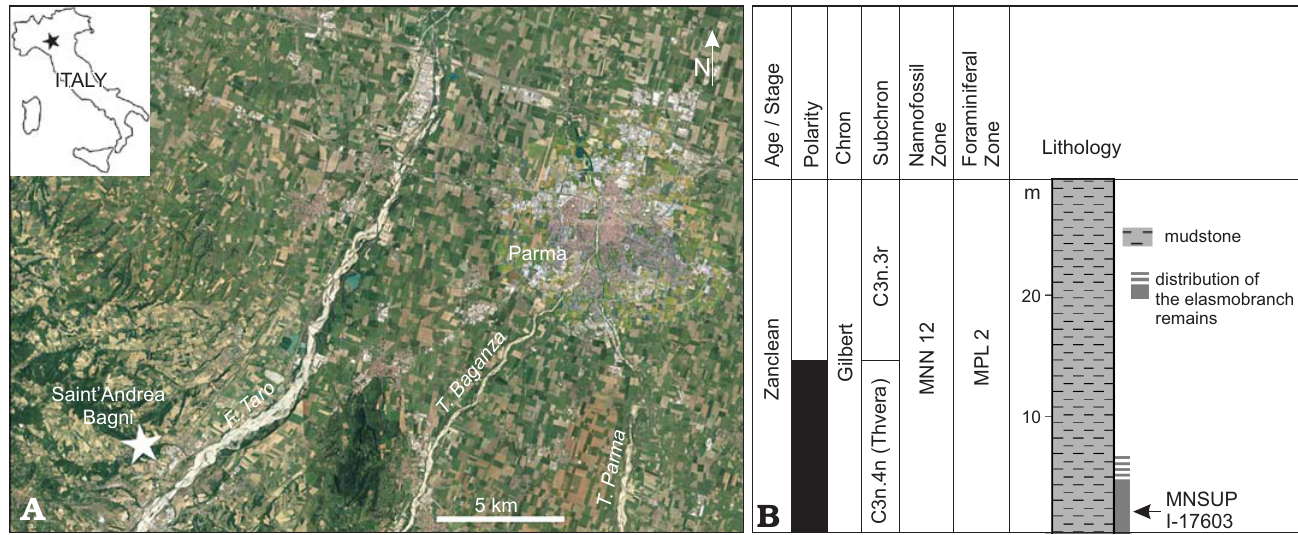
Fig. 1. A . Geographical position (star) of the lower Pliocene site of Sant’Andrea Bagni, Northern Apennines, northern Italy, where the holotype of Pliokogia apenninica gen. et sp. nov. (MSNUP I-17603) was discovered (image from Google Earth). B . Schematic stratigraphic section of the Pliocene succession exposed at Sant’Andrea Bagni (redrawn and modified after Channel et al.